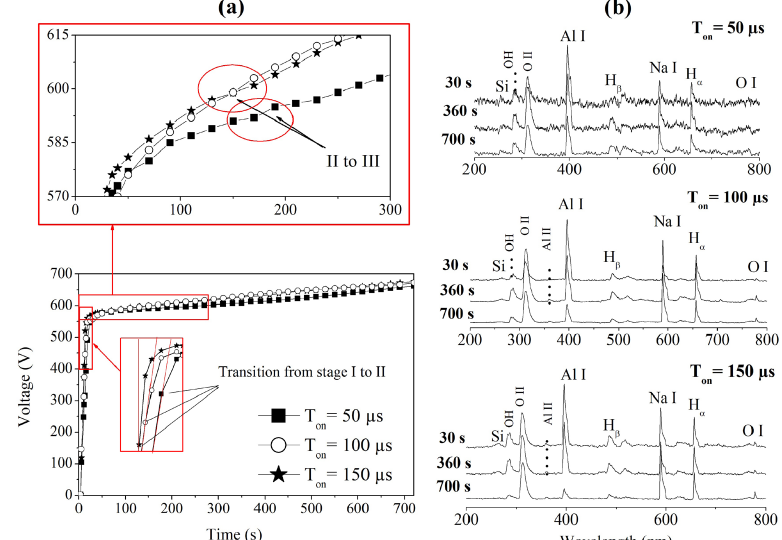
current pulse used on PEO process; (b) Variation of the optical emission on